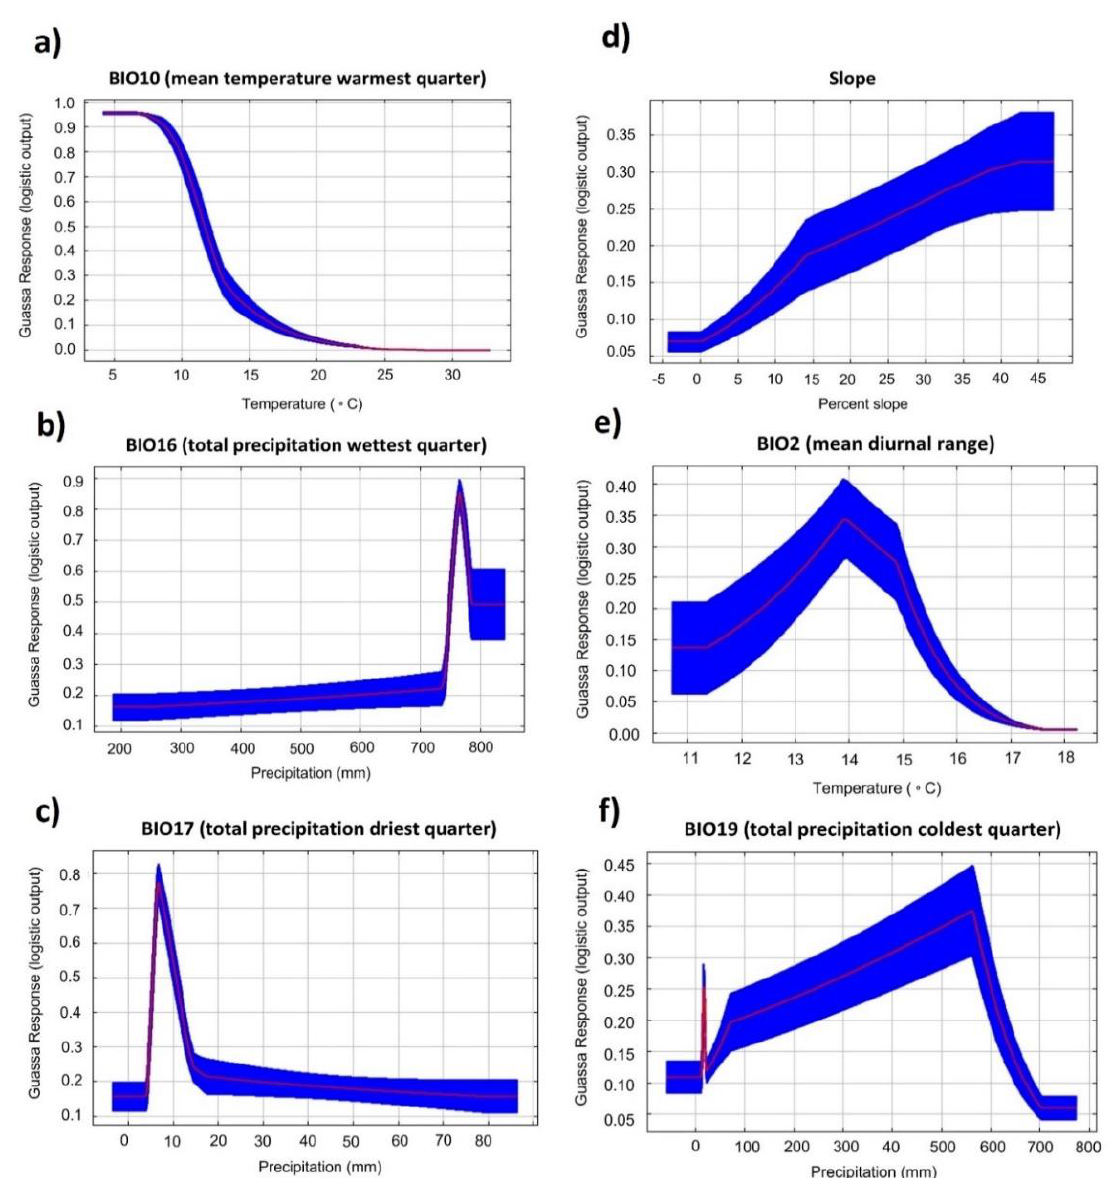
Figure 2. Marginal response curves showing how each environmental variable impacts the final model prediction for suitable guassa grass habitat. Each curve shows how the predicted probability of guassa presence changes as each variable increases (with all other variables held at their mean value). The variables include: ( a ) BIO10, the mean annual temperature of the warmest quarter, ( b ) BIO16, the total precipitation of the wettest quarter, ( c ) BIO17, the total precipitation of the driest quarter, ( d ) the slope (in percent), ( e ) BIO2, the mean diurnal temperature range, and ( f ) BIO19, the total precipitation of the coldest quarter. Table 2. Three existing protected areas and four proposed protected areas, describing the land area that falls within each class of suitable guassa grass habitat and what percent of the protected area that covers.